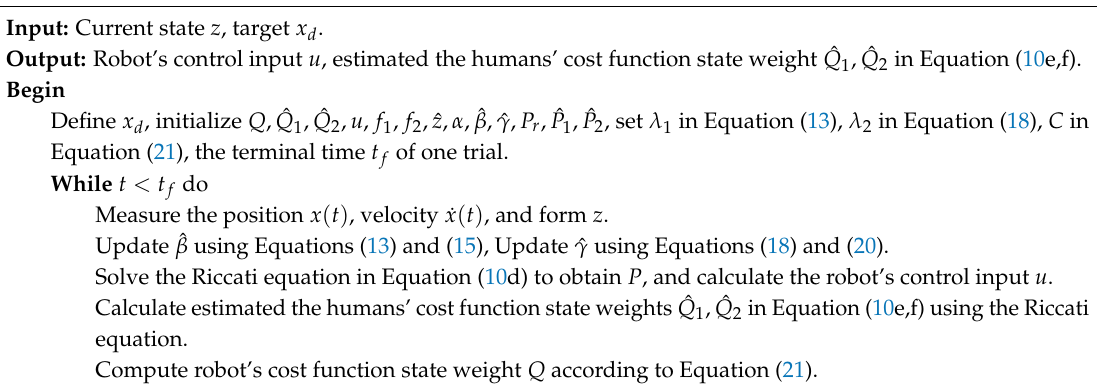
Algorithm 1 Adaptive optimal control algorithm based on N-player